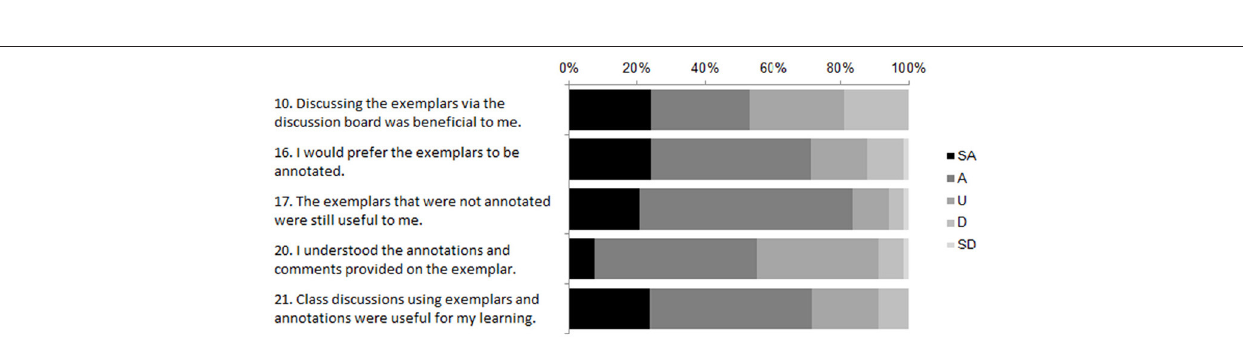
FIGURE 3 | Responses to questions about how many and what kinds of exemplars were most valued.